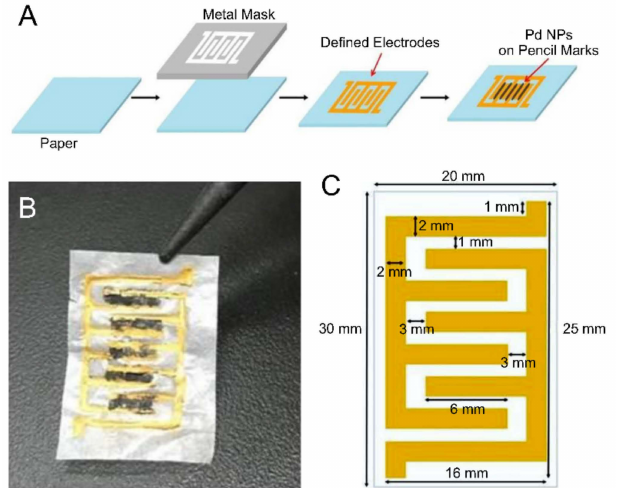
Figure 1. ( A ) Process for fabricating a paper-based sensor for hydrogen detection. ( B ) Photographic image of the fabricated sensor. ( C ) Schematic of the paper-based sensor. The gas sensor was produced by a metal-stencil printing technique and drawing with a 4B